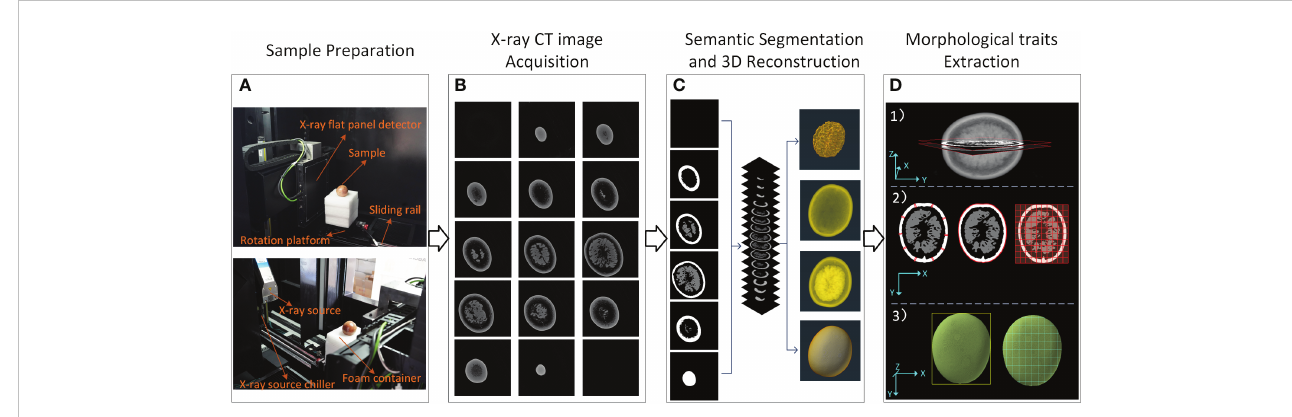
FIGURE 1 X-ray CT work fl ow of passion fruit measurements. (A) Composition of Micro-CT system and preparation of the sample. (B) Image acquisition. (C) Semantic segmentation and 3D reconstruction. (D) Morphological traits